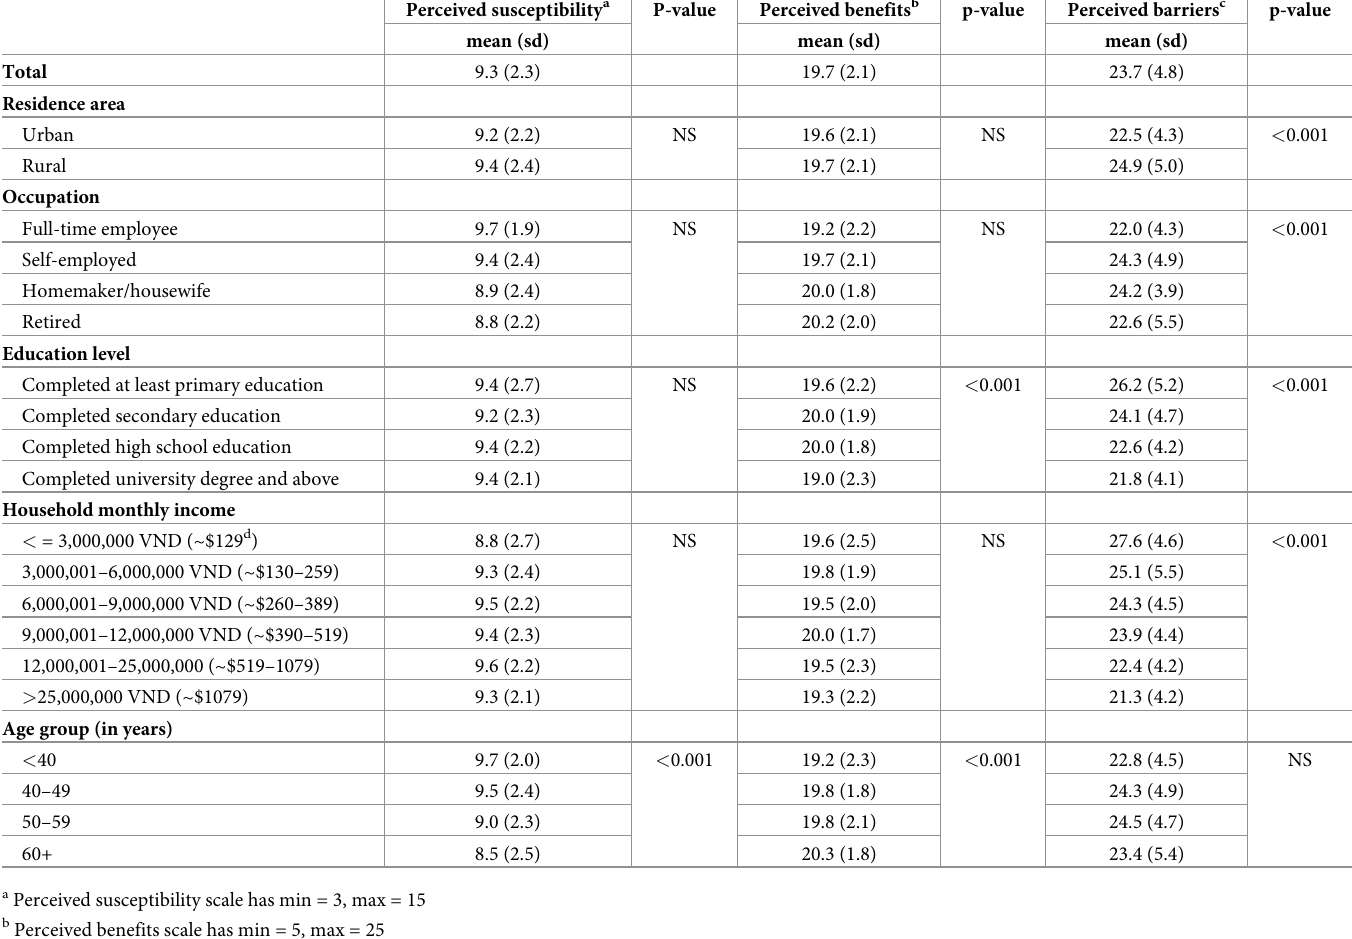
Table 3. Mean CHBMS subscale scores by sociodemographic